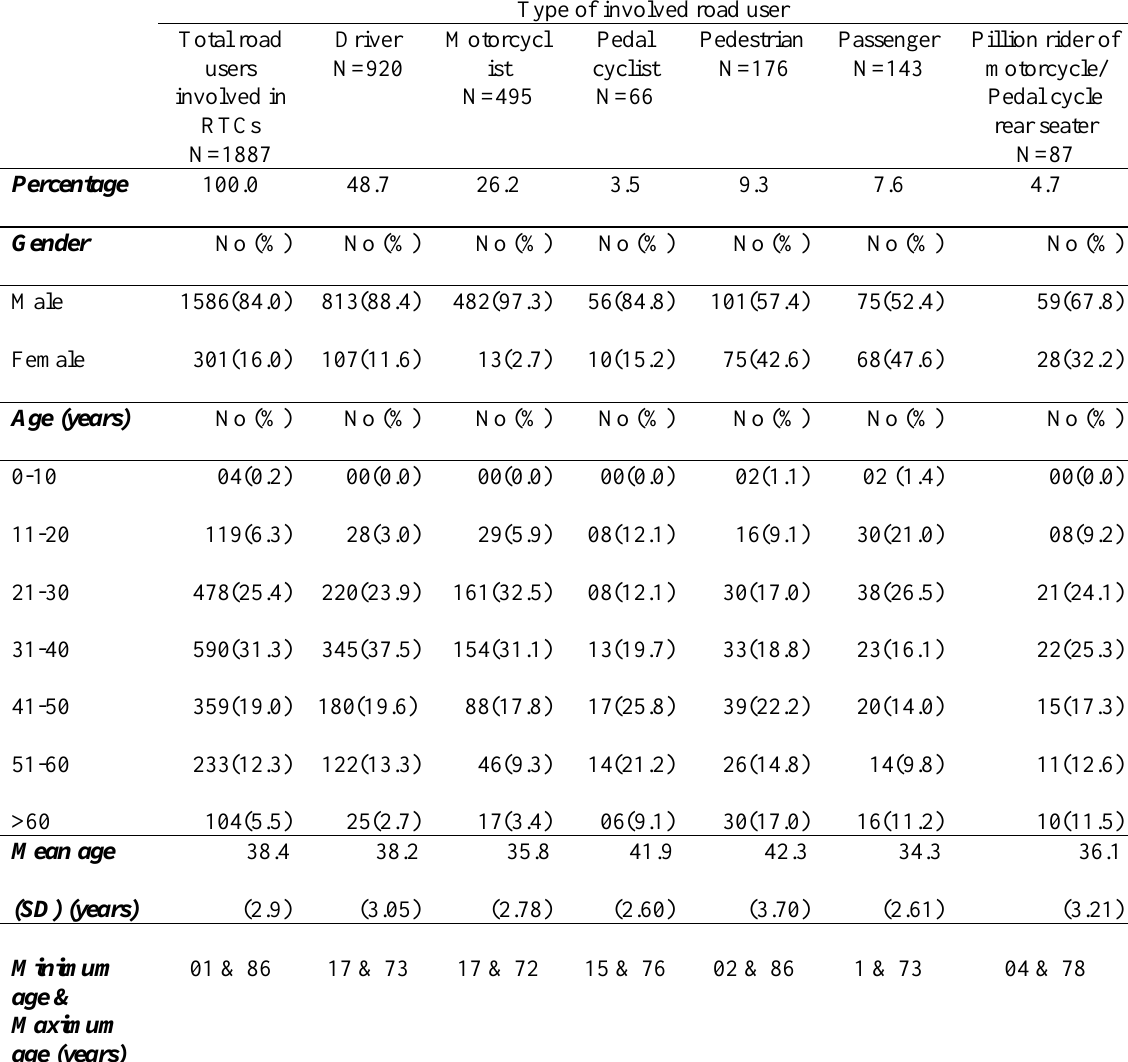
Table 5: Distribution of the gender, age and type of involved road user in KPD Type of involved road